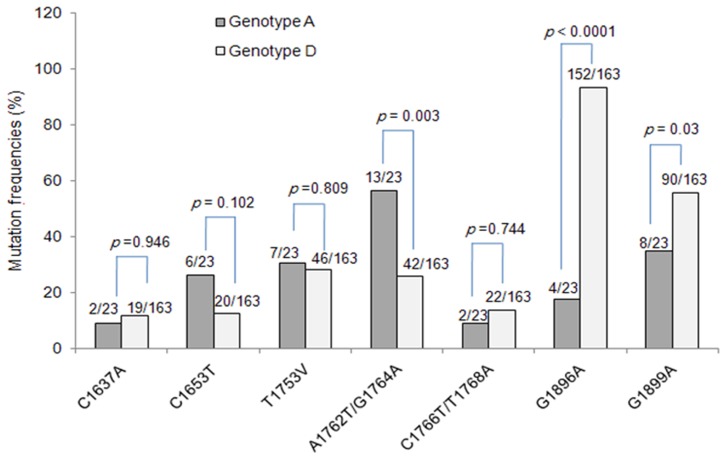
Prevalence of Pre-C and CP mutations according to HBV genotypes A and D.